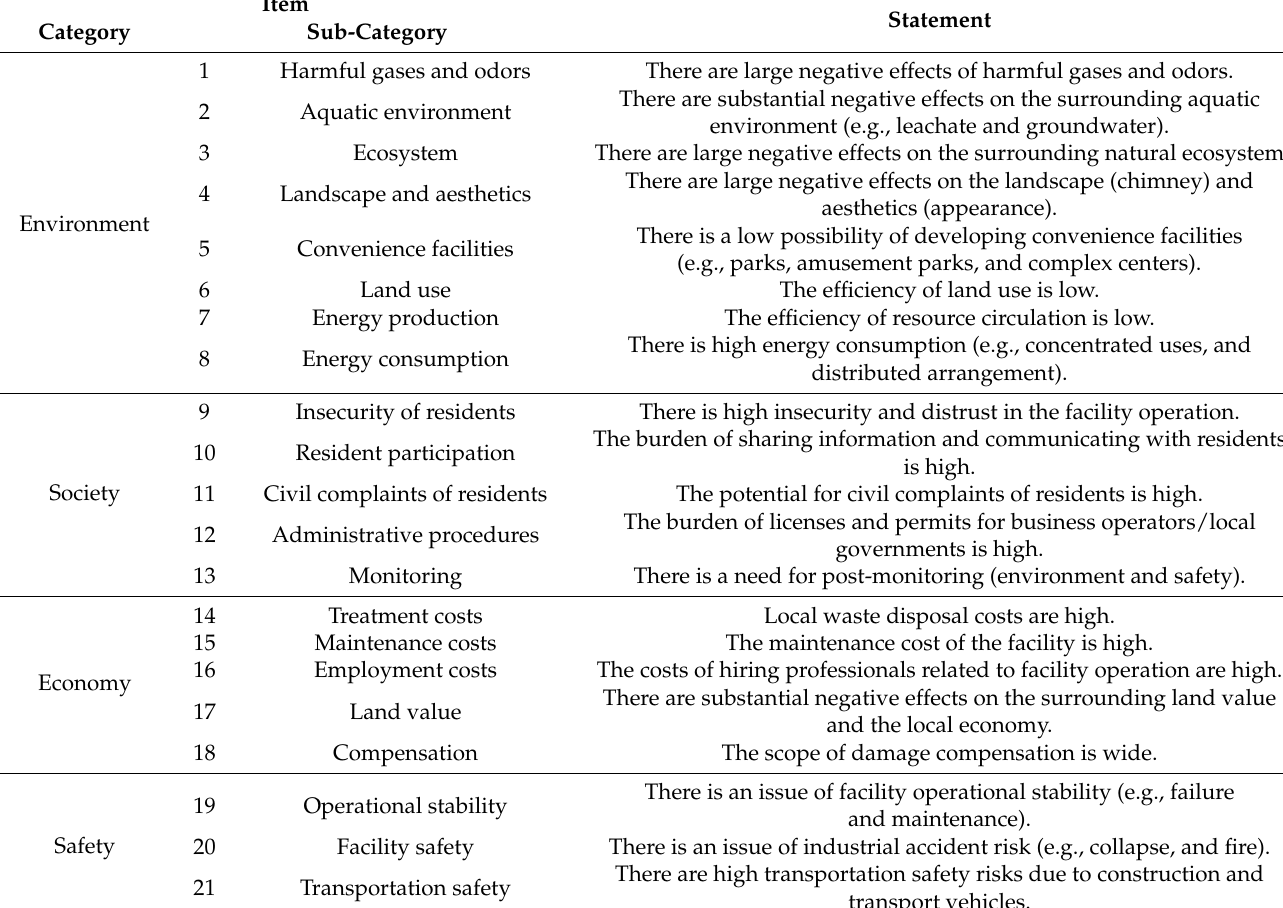
Table 1. Selected Q statements included in the perception survey.